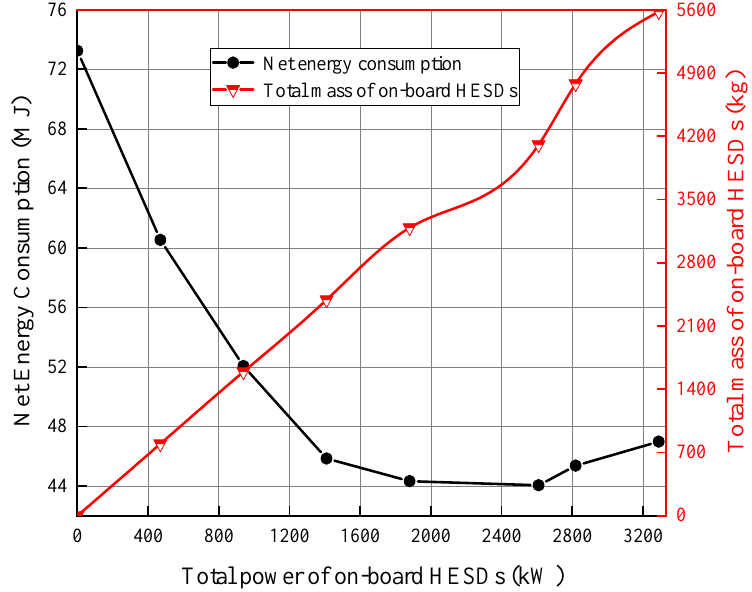
Figure 9. Relationship between NEC and total mass of on-board HESDs with different sizes.